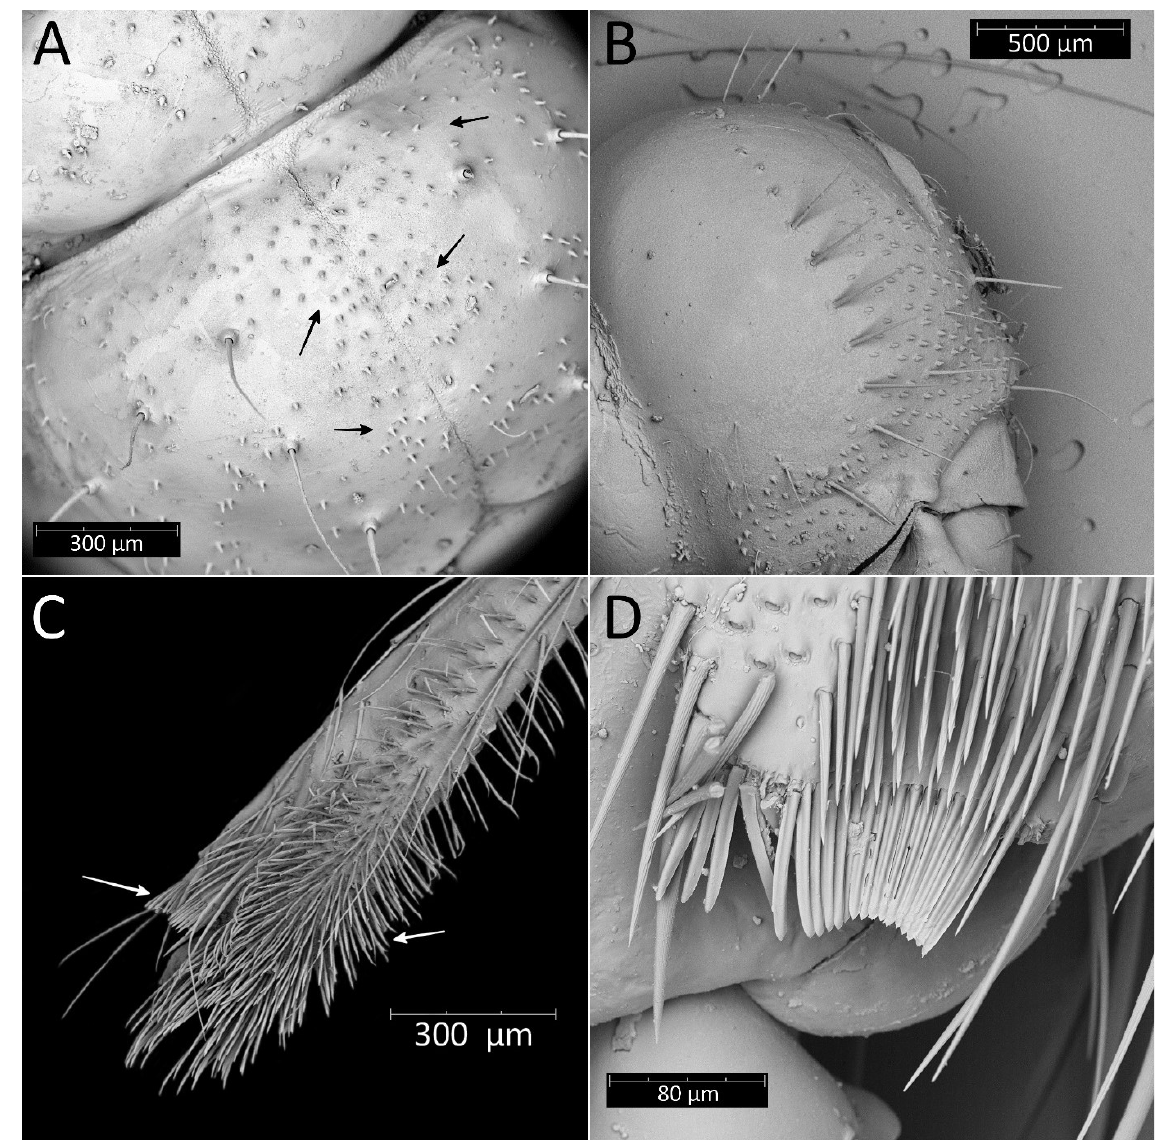
Figure 6. ( A ) Thorax of the first instar of Psyttala horrida (Stål, 1865) covered with short and robust spine-like processes; ( B ) coxa with long setae, arranged in the regular line, dorsal view; ( C ) pad of barbed setae on ventral apical part of fore- and middle tibia (arrow on the right); foretibial comb—arrow on the left; ( D ) foretibial comb, at larger magnification. Second Instar Colouration: Head and thorax same as in the first instar nymphs. Antennomeres with very dark brown scape and pedicel. Basiflagellomere with dark brown basal part gradually paler into the apex, distiflagellomere brown. All segments covered with brown setae. Legs with brownish-red coxa and brown trochanter. Femur yellow with dark brownish-red basal and red apical parts, covered with light brown setae. Tibia yellow with red basal and pale brown apical parts, covered with yellowish setae. Tarsus pale brown. Abdomen brownish-dark pink with red and dark brown muscle attachments, plates, and spine-like processes on the dorsal part. Last segment of the abdomen dark brown. Single red spot in the central part of the fourth and fifth abdominal segments, seen ventrally (Figure 7).